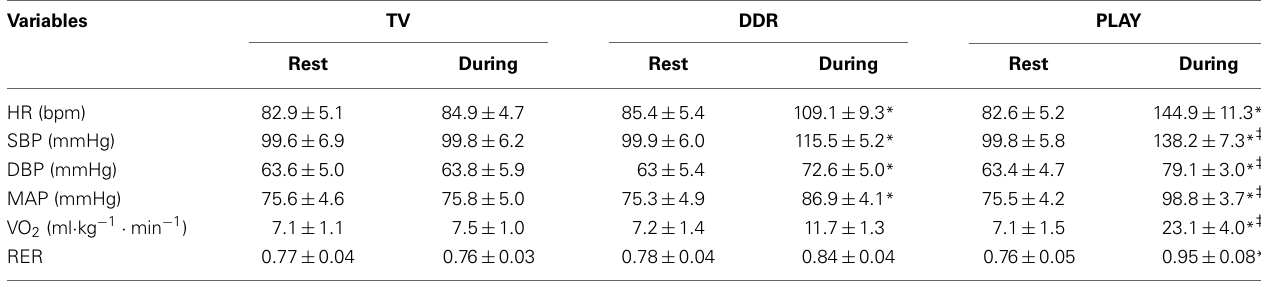
Table 1 | Cardiovascular and ventilatory responses at rest and during each session. Variables